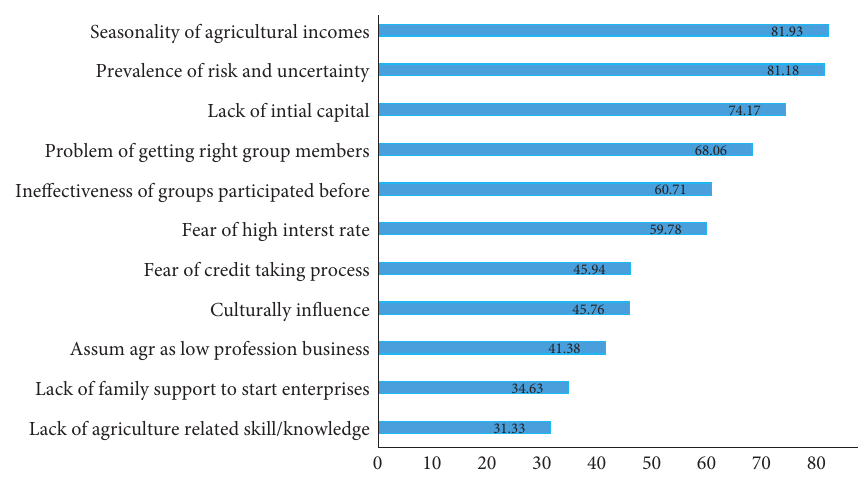
Figure 4: Factors affecting youth participation.